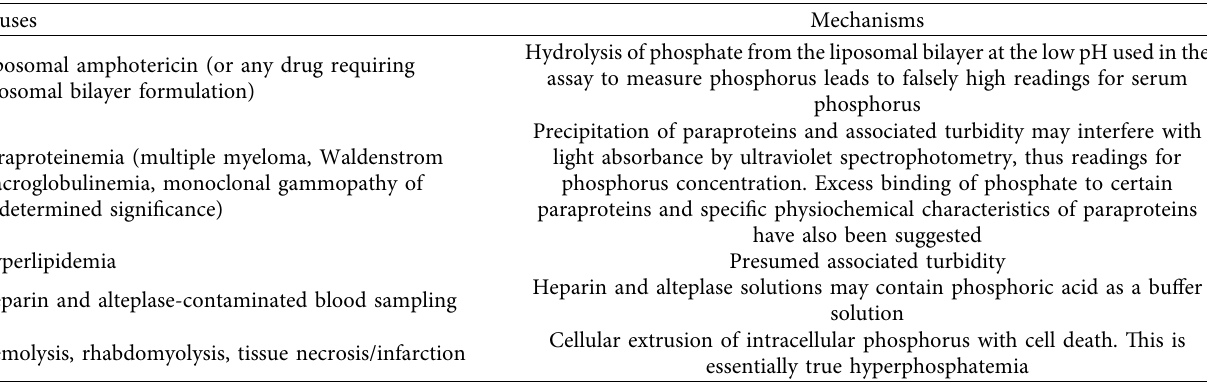
Table 3: Causes of